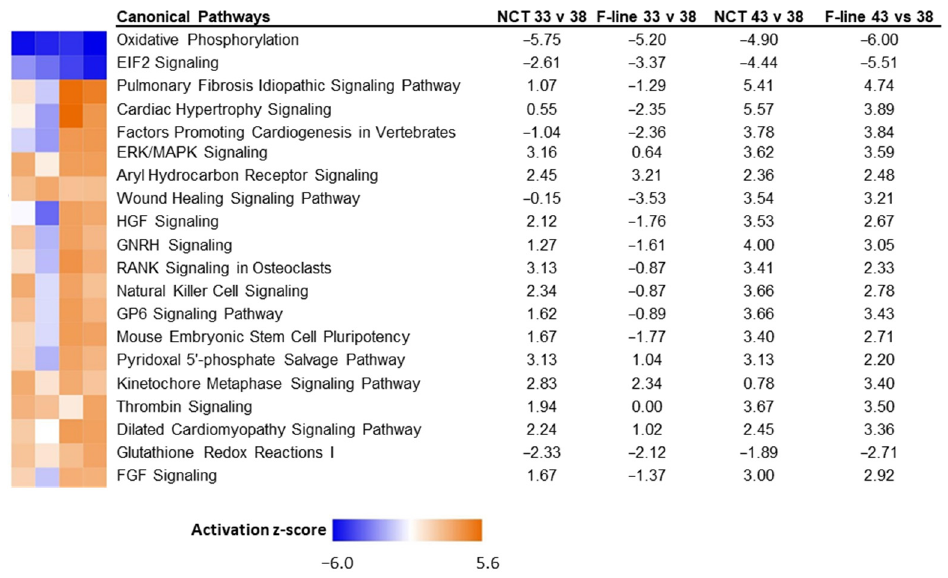
Figure 9. Significant canonical pathways identified in IPA Comparison analysis of genes expressed in skeletal muscle SCs of NCT versus F-Line at 33 ◦ C and 43 ◦ C compared to controls (38 ◦ C). Only the 20 pathways with highest absolute z-scores are